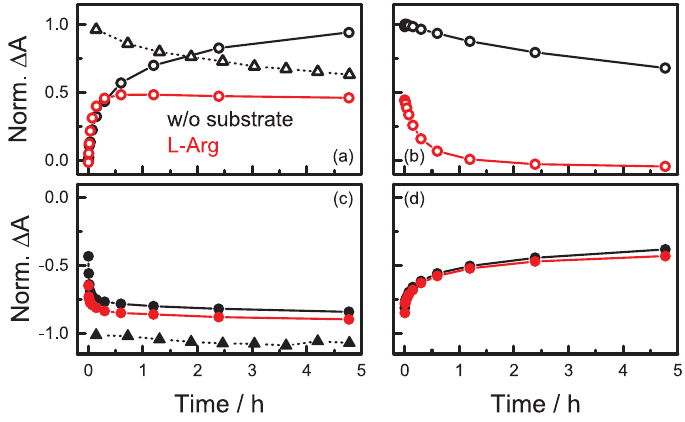
Figure 7. Temporal development of the integrated absorbance of the bands of 5C ferric iNOS (filled symbols) ( a , c ) during constant illumination at 4 K (circles: 10 mW, 532 nm; triangles: 300 mW, 532 nm) and ( b , d ) after the laser was switched off. Black: iNOS -NO; red: iNOS oxy oxy